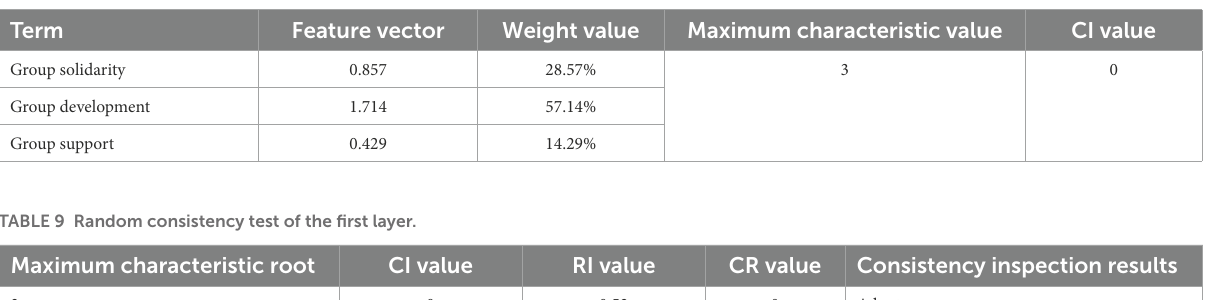
TABLE 8 AHP analysis results.